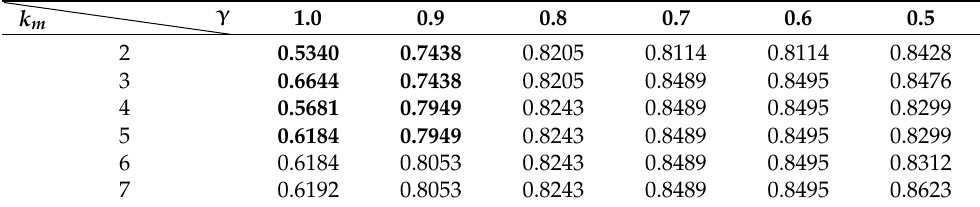
Table 6. MREs of predicted results.